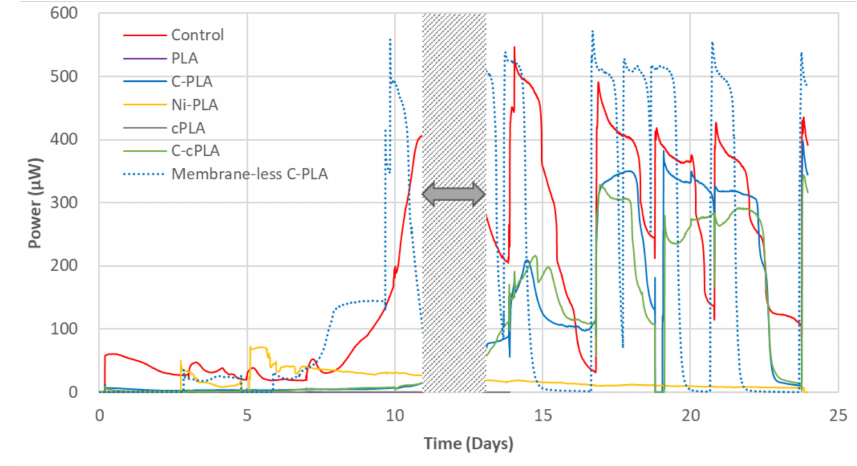
Figure 1. Power output of test anode materials. “C” and “c” in the sample names stand for “carbon-coated” and “conductive” respectively. For details of each test material, see Section 3.3. The grey-colored area indicates when data logging stopped for other electrochemical analysis of the cells. Data points are average values of